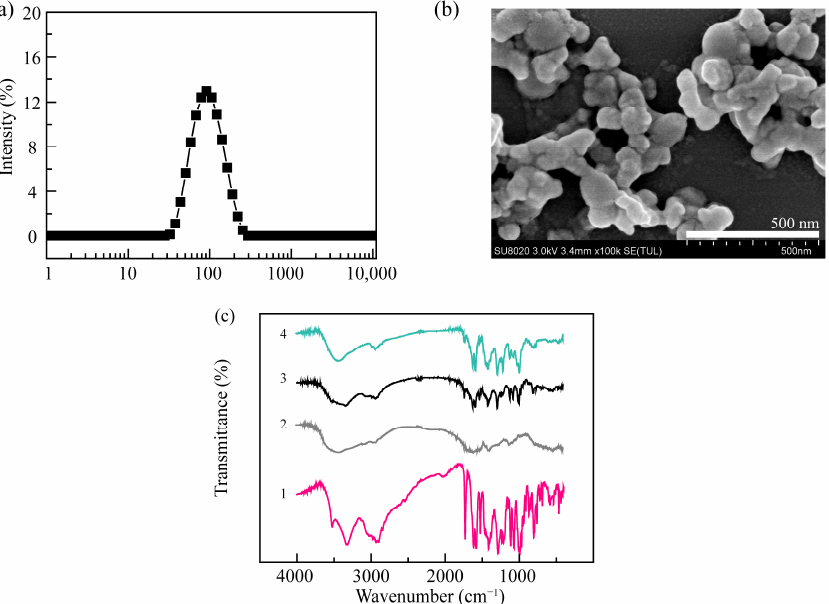
Figure 2. Particle size distribution curve of α -PGA/DOX NPs detected by dynamic light scattering ( a ); SEM image ( b ), scale bar 500 nm; FT-IR spectra ( c ) of DOX (1), PGA (2), physical mixture (3), and α -PGA/DOX NPs (4).